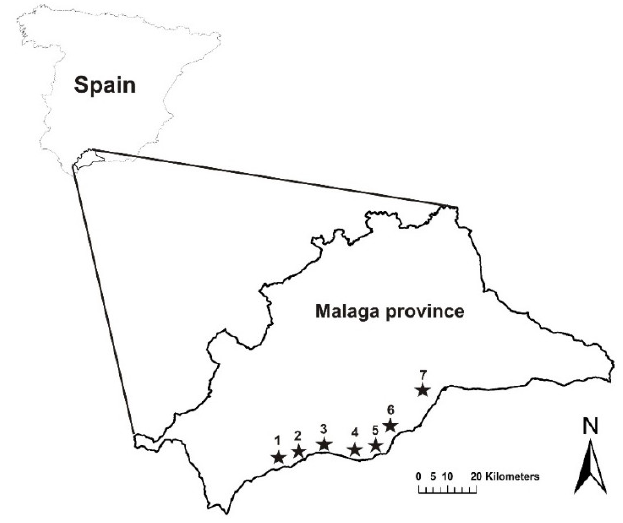
Figure 1. Study area and schematic location of the urban areas where a Feral Pigeon control pro- gramme was implemented (black stars). The numbers represent the location of each building in the study area (Map_ID; see Table S1). This figure was prepared in ArcGIS 10.6 (Geographical Infor- mation System, ESRI, https://www.arcgis.com/ accessed on 8 November 2021)).